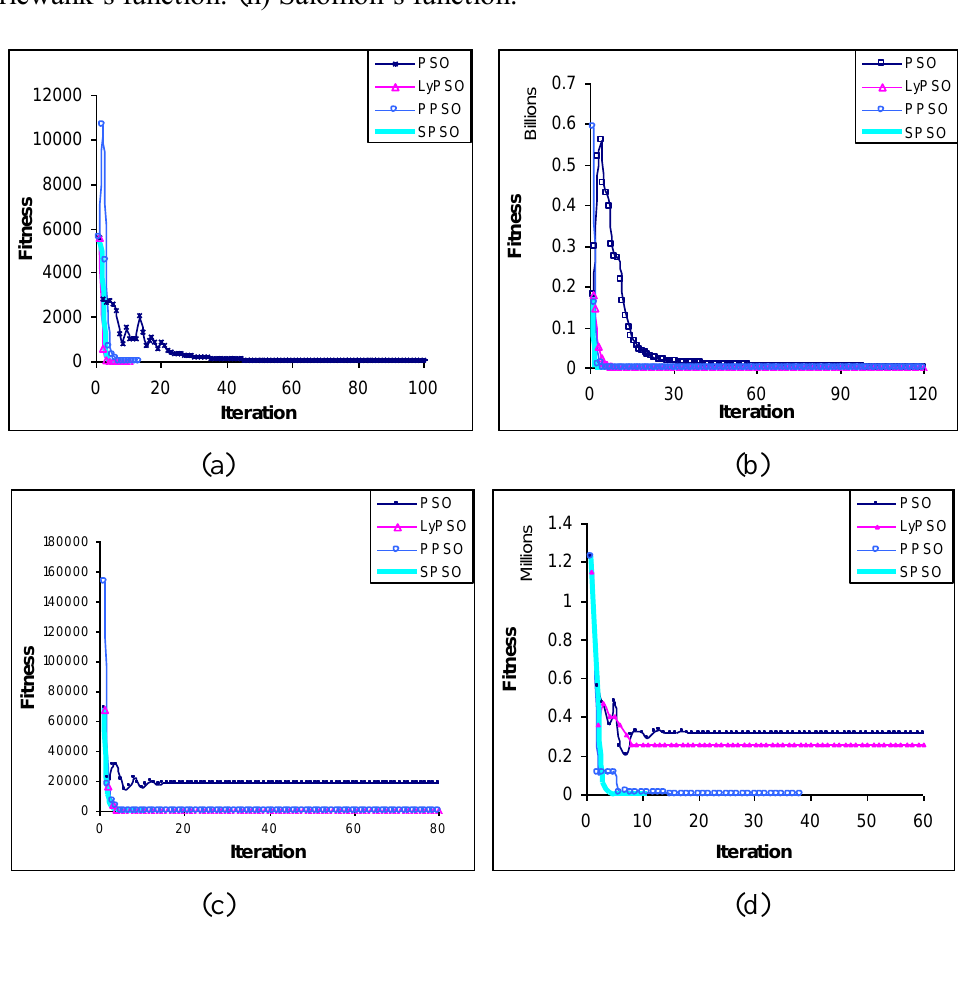
Figure 2. Progress towards the optima: (a) Sphere function. (b) Rosenbrock’s function. (c) Step function. (d) Schwefel’s Problem 1.2. (e) Rastrigin’s function. (f) Ackley’s function. (g) Griewank’s function. (h) Salomon’s